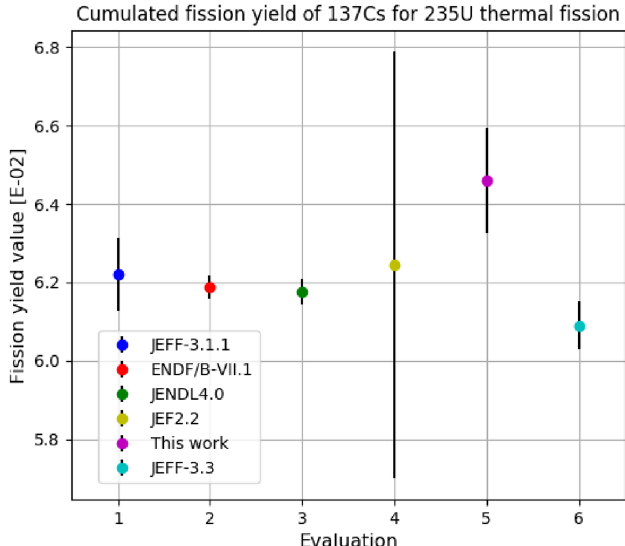
Fig. 4. 235 U cumulated thermal fi ssion yields in 137 Cs from various nuclear data evaluation (1 s ).